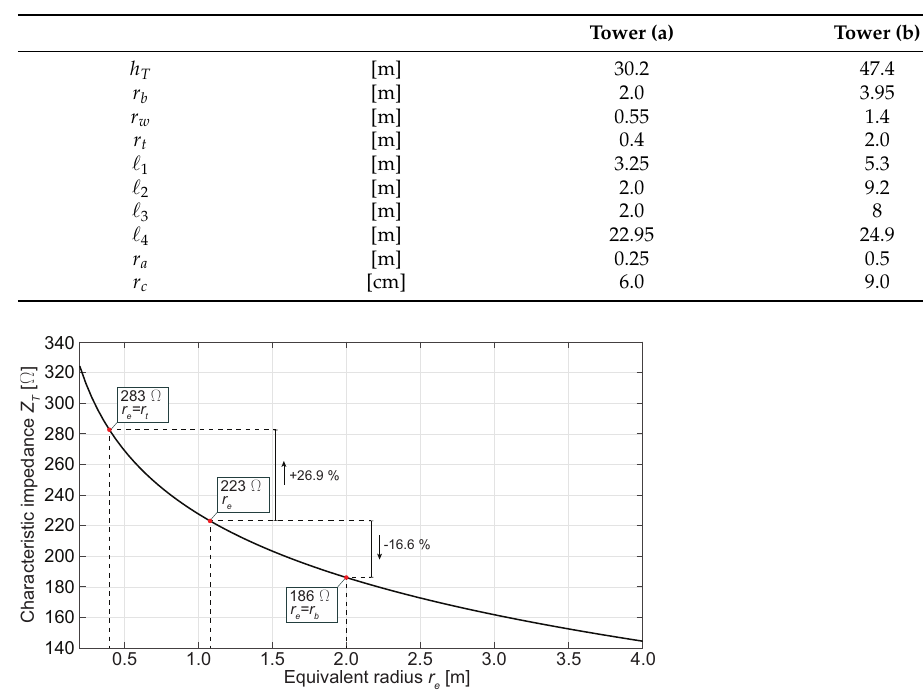
Table 6. Geometrical characteristics of the towers under analysis.